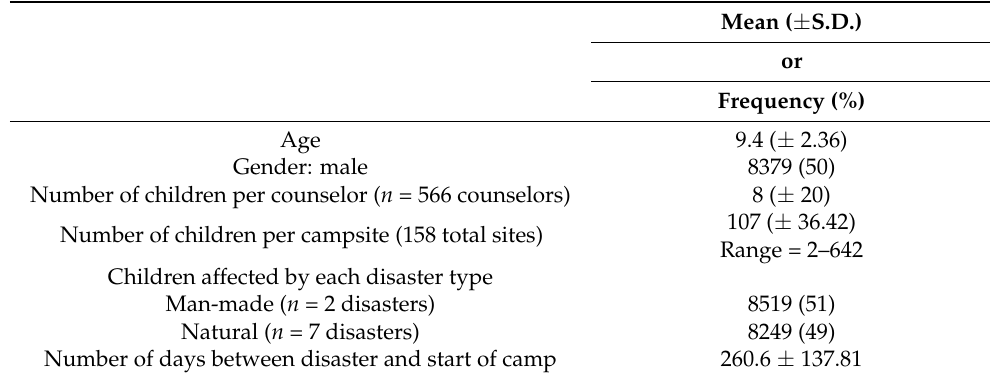
Table 1. Sample characteristics.